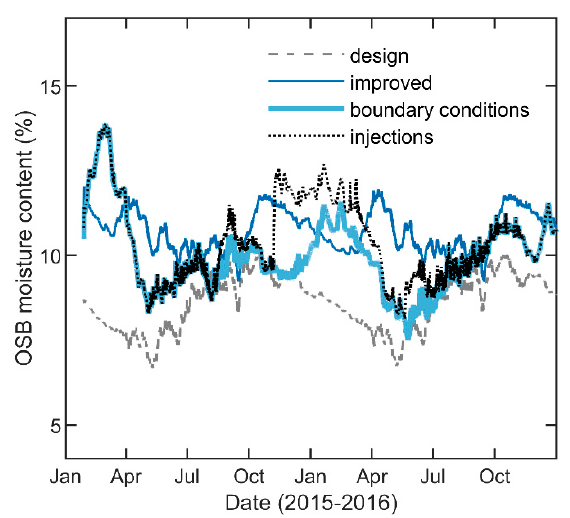
Figure 12. Simulated moisture content of OSB in wall 3 (MW, kraft N) under different model conditions.